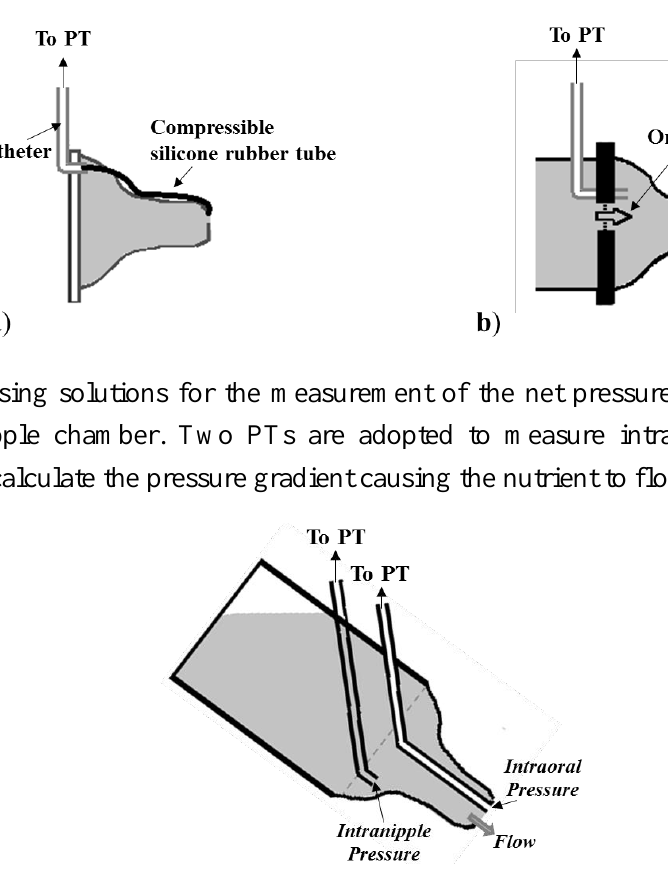
Figure 5. Sensing solutions for EP measurement: ( a ) a PT measures EP by means of the compression of a silicone tube inserted into the catheter connected to the transducer;